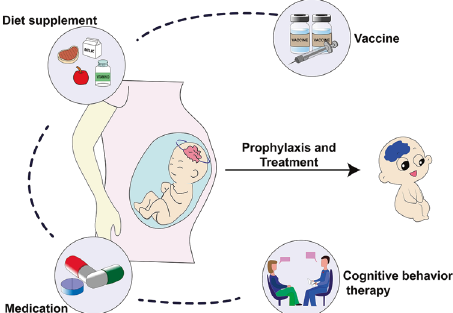
Fig. 2 Prophylactic and treatment strategies. Effective prophylactic and treatment strategies for potential risks of offspring ’ s neuropsy- chiatric disorders in pregnant women during the COVID-19